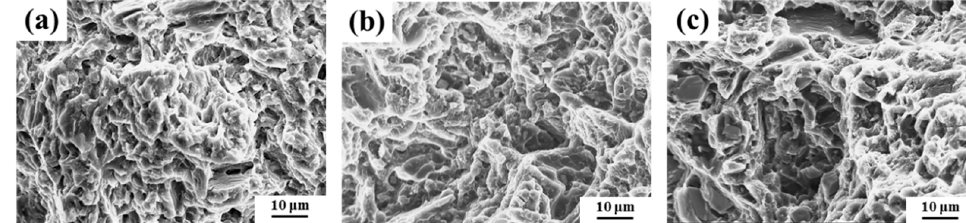
Figure 10. SEM micrograph of fracture at room temperature: ( a ) Mg-4Al-4 (La, Ce); ( b ) Mg-4Al-4 (La, Ce)-1Sm; ( c ) Mg-4Al-4 (La, Ce)-2Sm.